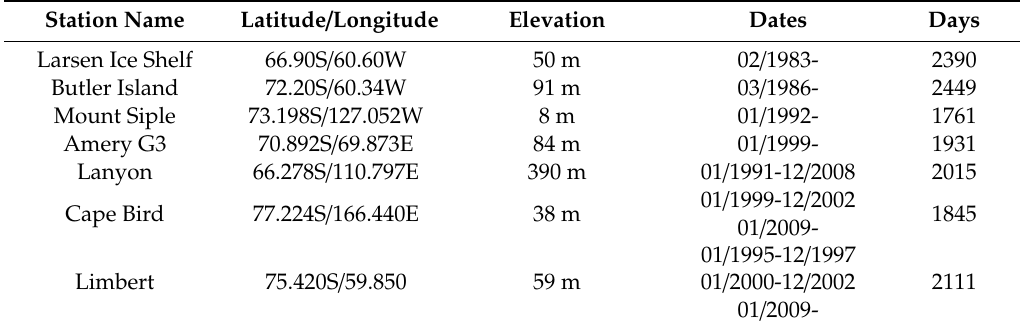
Table 2. Automatic weather stations (AWS) for the evaluation of the snowmelt detection methods. (The AWS can be obtained from http: // amrc.ssec.wisc.edu / aws / ).